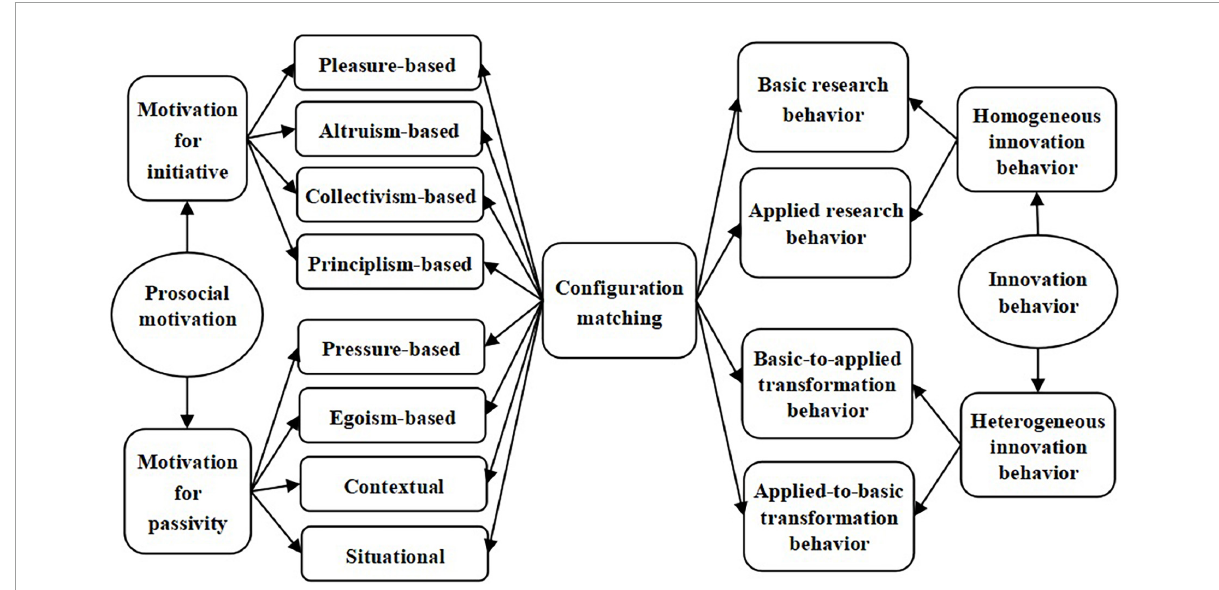
FIGURE1 Theoretical model of the effect of multidimensional prosocial motivations on different types of innovation